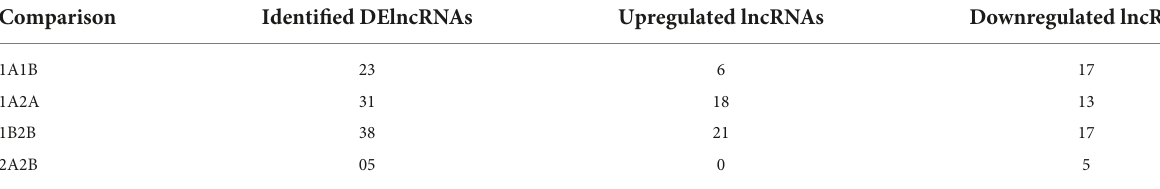
TABLE 1 Number of differentially expressed lncRNA in various comparison sets. Comparison